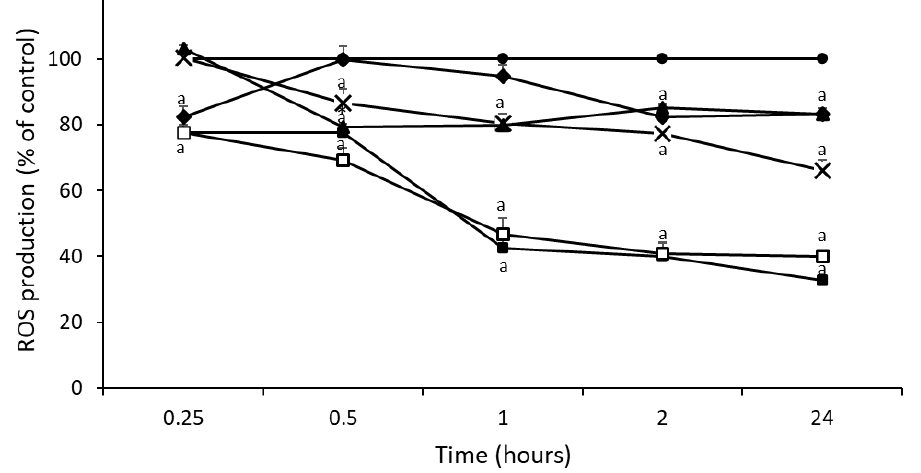
Figure 2. Time course of ROS production in untreated HepG2 cells ( ● ) and treated with NAC ( ■ ), sample 2 (TH + 2RJ) ( ▲ ), sample 3 (TH + 10RJ) ( ◆ ), sample 4 (TH + 2PR) (X), and sample 5 (TH + 10PR) ( □ ). Significant difference from control a p < 0.05.